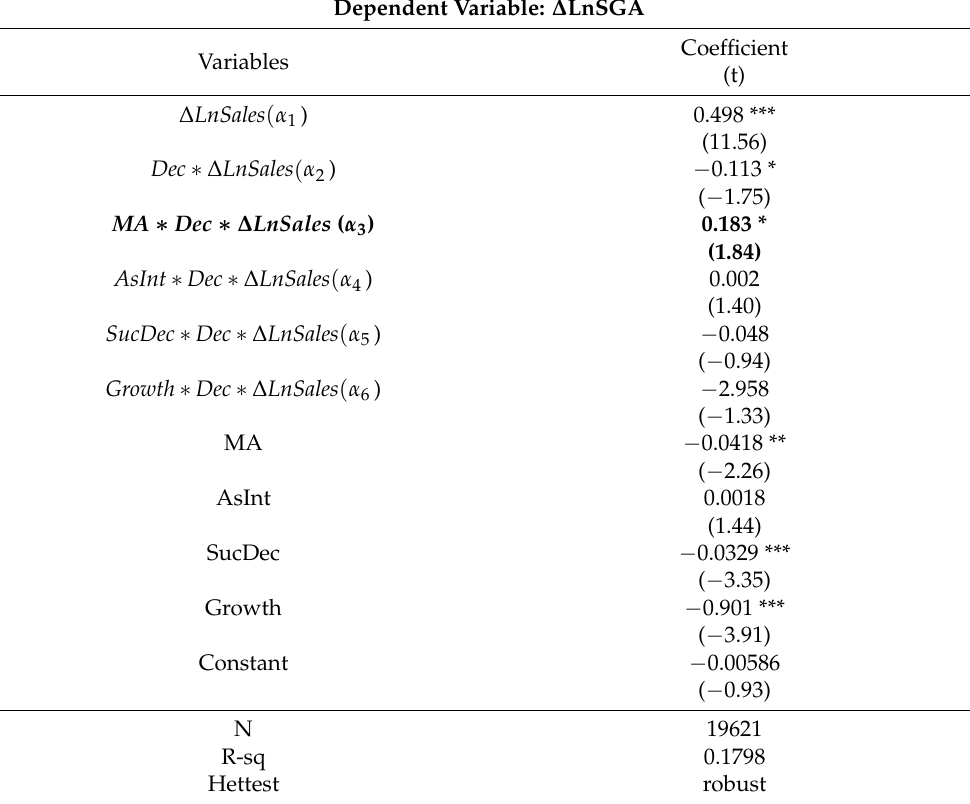
Table 8. Robustness test